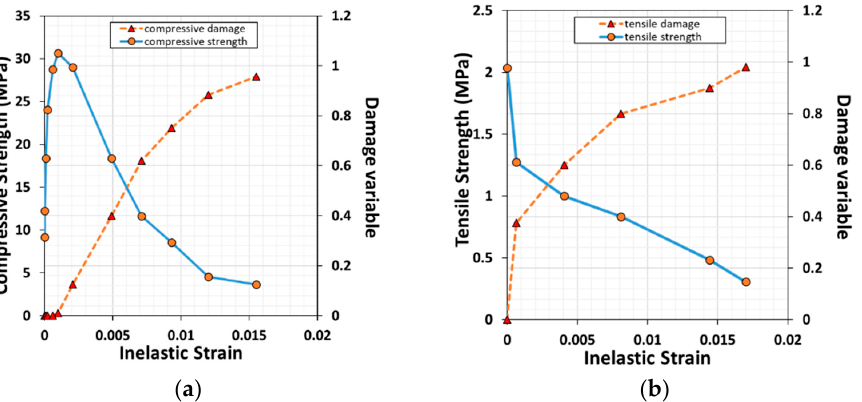
Figure 5. ( a ) Inelastic material behavior of compressive concrete. ( b ) Variations in tensile strength and damage.